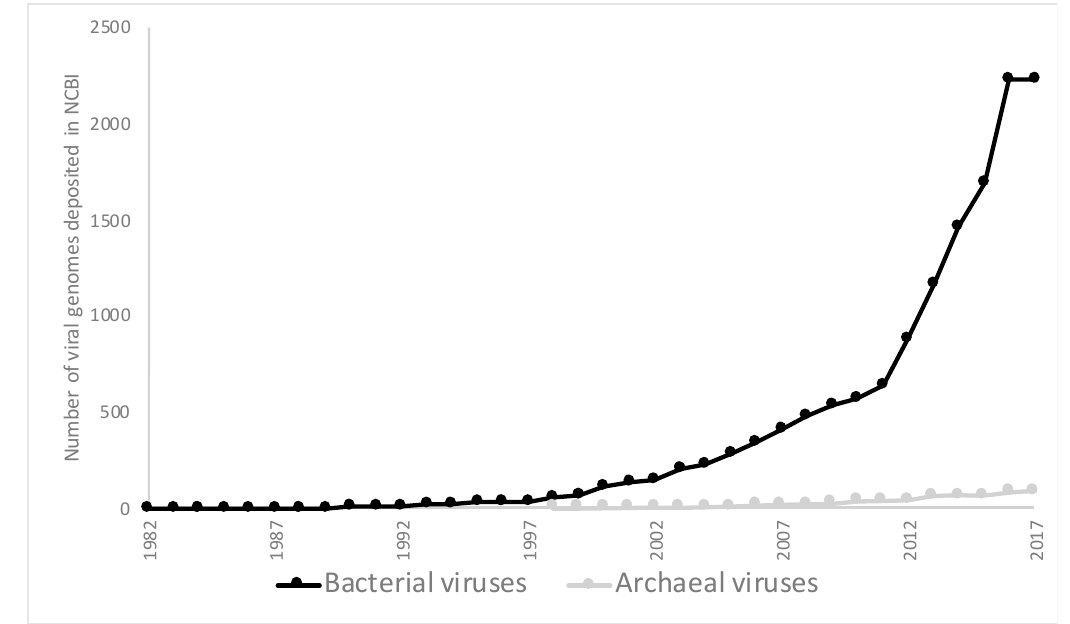
Figure 1. Number of bacterial and archaeal viruses that have been fully sequenced and deposited in the NCBI viral genome database on 6 December 2017 [27].